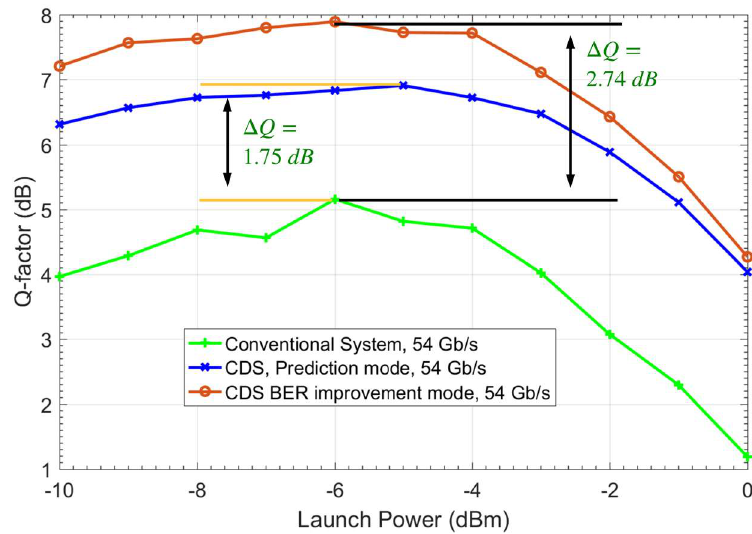
Figure 18. The simulation results for the quality-factor versus launch power for the conventional system, CDS prediction mode, and CDS improvement mode.